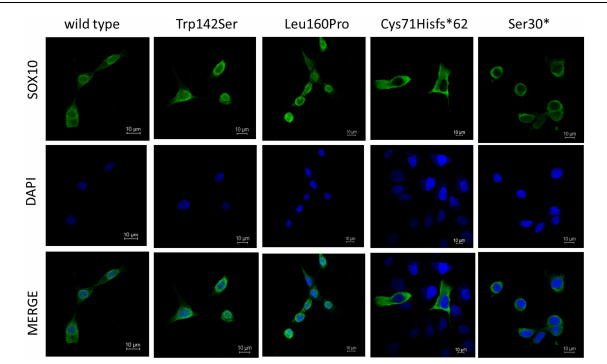
FIGURE 4 | Subcellular localization of SOX10 variants. Wild-type and mutant SOX10 proteins shown in green and DAPI, revealing nucleus, shown in